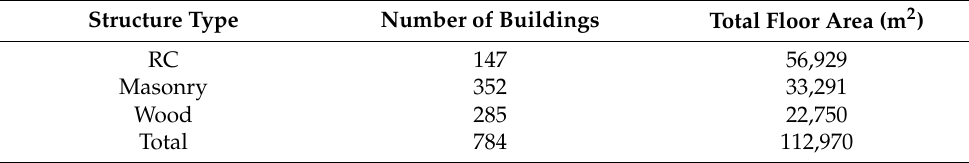
Table 1. Building status of raw data used in this study.